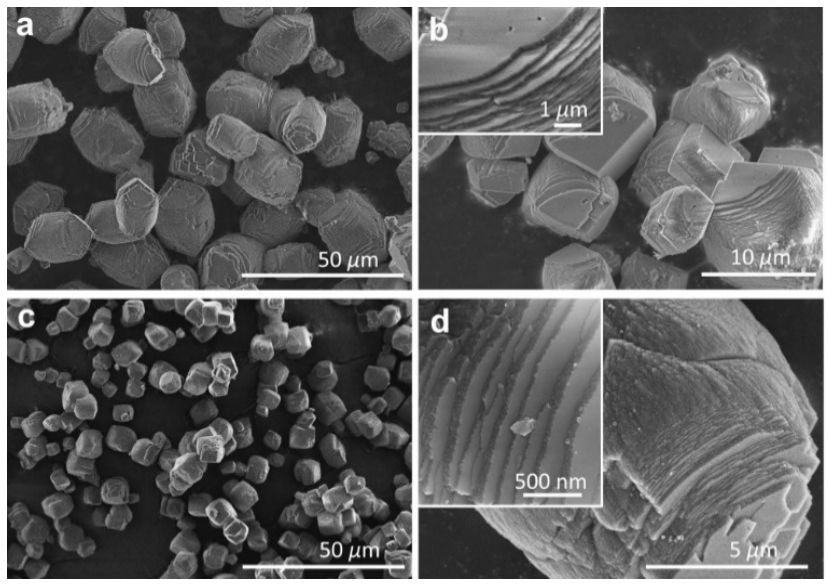
Figure 1. SEM micrographs showing the structural features of ( a , b ) MgCO 3 and ( c , d ) MgO assembled by nanosized laminates.